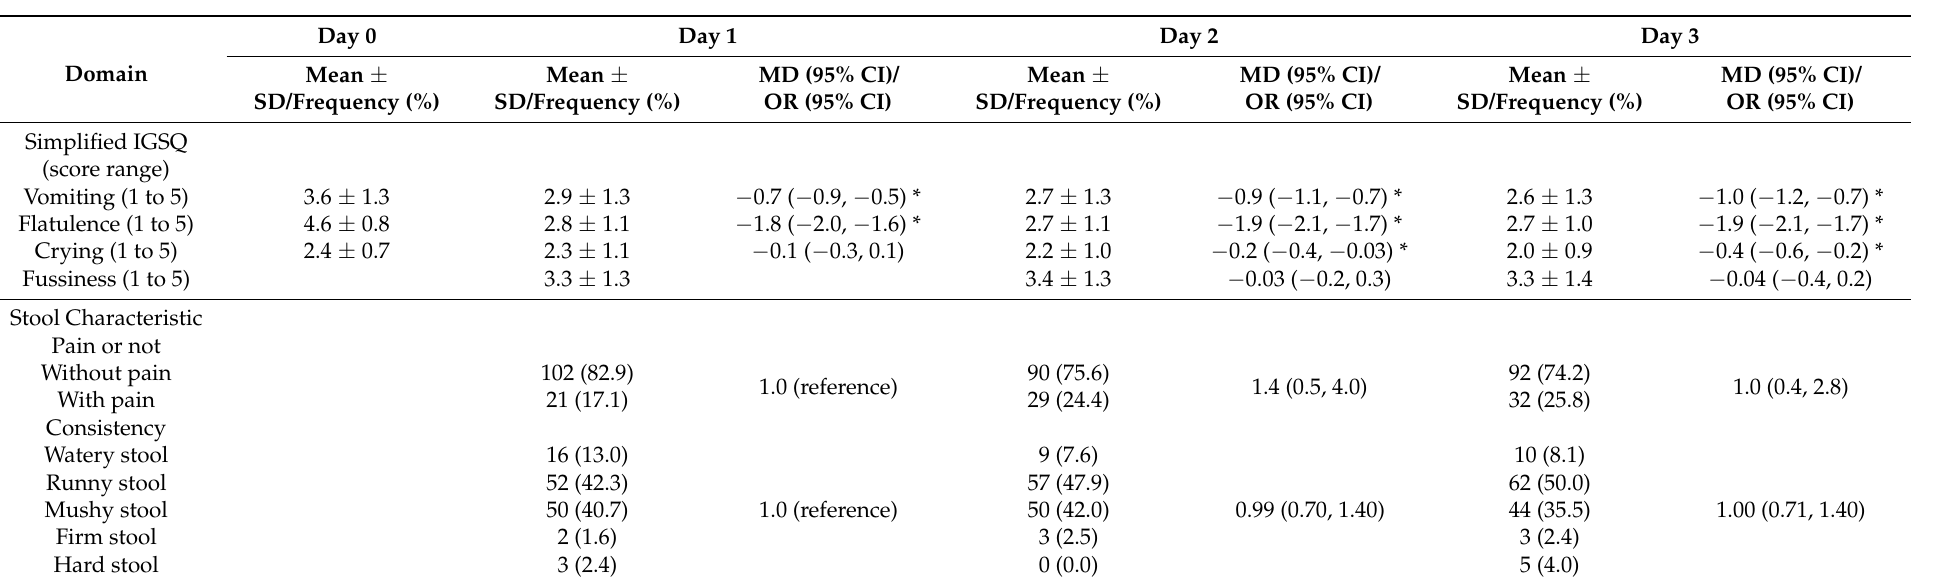
Table 3. Simplified IGSQ scores and stool characteristics in the first 3 days of feeding